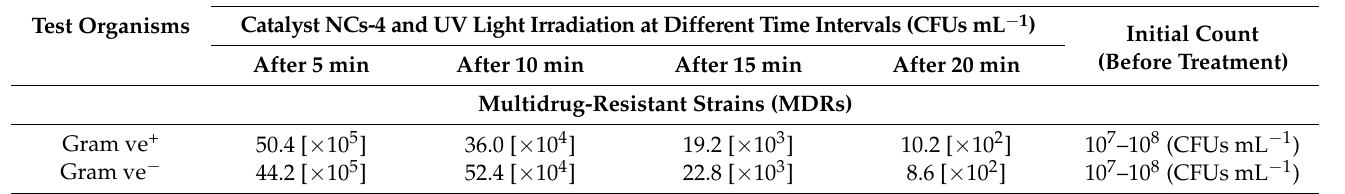
Table 2. Photocatalytic inactivation test by using bimetallic nanocomposites BiPO 4 /ZnO-NCs (B1Z4- 75:300; NCs-4) catalyst under UV light exposure. Photocatalytic Inactivation